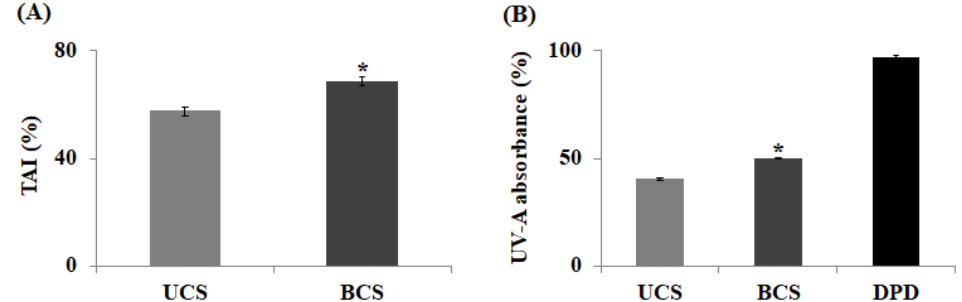
Figure 2. The values of TAI change ( A ) and UV-A absorption change ( B ) by bioconversion using L. plantarum SM4. UCS: ultrasound-assisted extracts of chestnut inner shell; BCS: bioconverted chestnut inner shell extracts; TAI: tyrosinase activity inhibition. All values are means in triplicate measurement and the statistical analysis of the data was conducted by a t -test. Bars marked with asterisks are significantly different from the control (* p < 0.05).